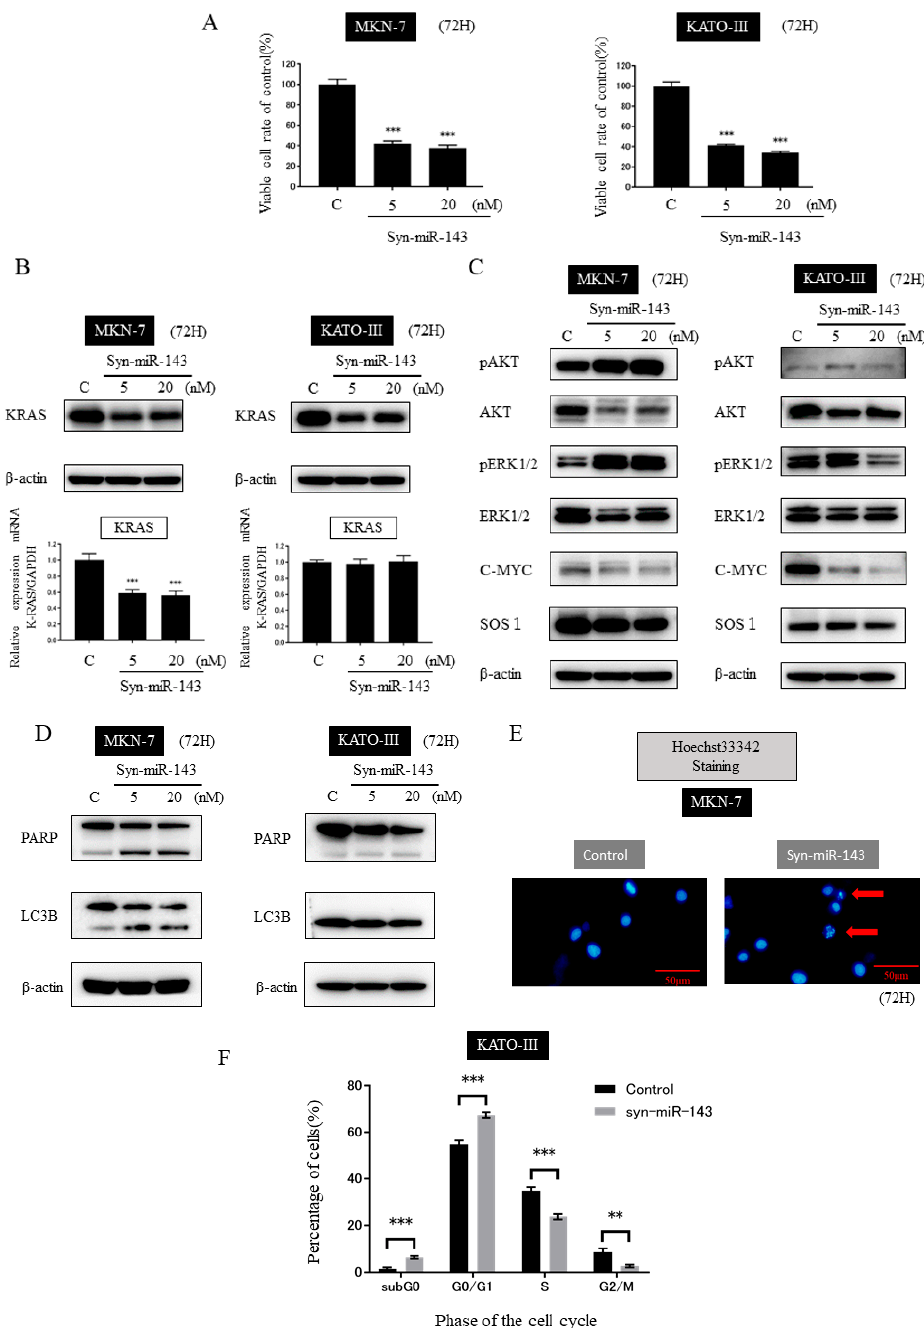
Figure 2. Ectopic expression of miR-143 in gastric cancer cells MKN-7 and KATO-III. ( A ) Cell viability at 72 h after transfection of MKN-7 and KATO-III cells with control RNA or synthetic miR-143 syn-miR-143. ( B ) Western blot analysis and qRT-PCR of KRAS expression at 72 h after transfection with control RNA (20 nM) or syn-miR-143 (5 nM, 20 nM). Densitometric values of KRAS/ β -actin were calculated, and the values of controls are indicated as “1”. ( C ) Western blot analysis of the expression levels of AKT, pAKT, ERK1/2, pERK1/2, C-MYC, and SOS1 at 72 h after transfection with control RNA (20 nM) or syn-miR-143 (5 nM, 20 nM). ( D ) Western blot analysis of PARP and LC3B at 72 h after transfection with control RNA (20 nM) or syn-miR-143 (5 nM, 20 nM). ( E ) Hoechst 33342 staining of MKN-7 cells at 72 h after transfection with control RNA (20 nM; left) or syn-miR-143 (20 nM; right). The typical apoptotic features, such as chromatin condensation and fragmentation of nuclei, were observed (red arrows). ( F ) Cell-cycle analysis of KATO-III cells after transfection with control RNA (5 nM) or syn-miR-143 (5 nM). Results are presented with the mean ± SD; ** p < 0.01; *** p <